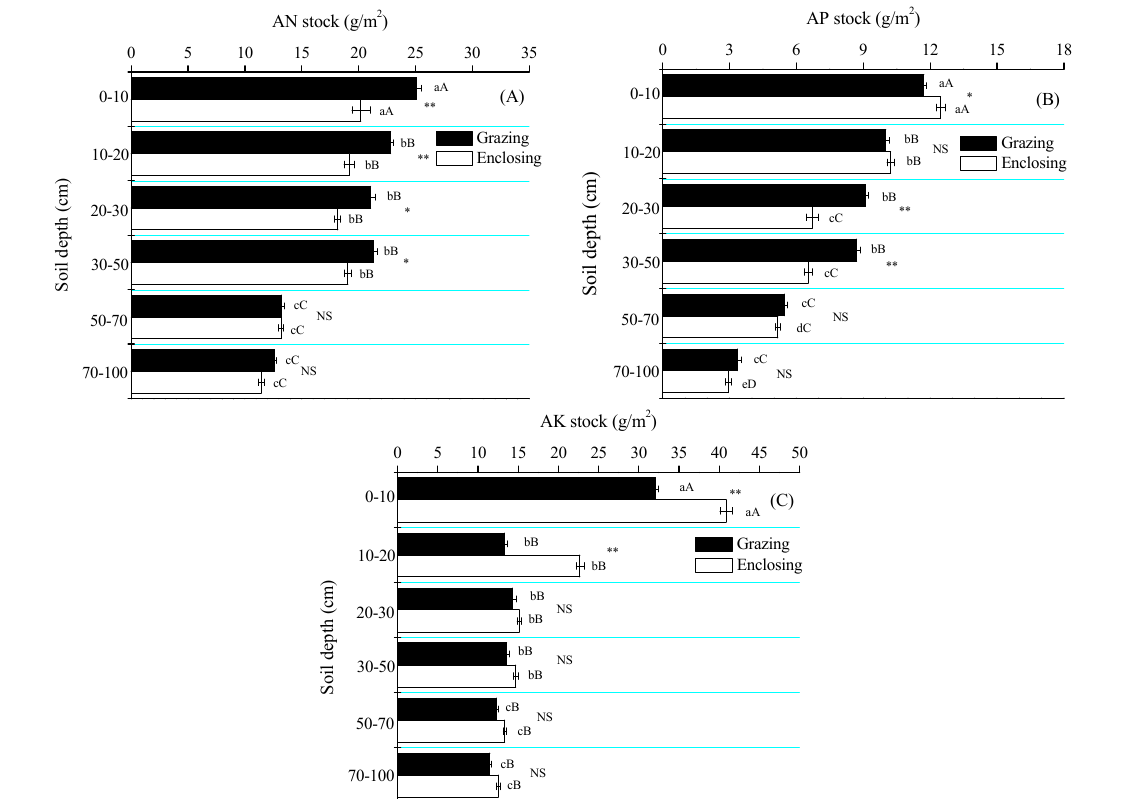
Figure 7. The soil AN ( A ), AP ( B ), and AK ( C ) stocks of treatments. Note: * and ** show significant differences at p < 0.05 and p < 0.01 of AN, AP, and AK stocks in each soil layer between two treatments, and NS shows no significant difference ( t -test). Lowercase and capital letters show significant differences at p < 0.05 and p < 0.01 of AN, AP, and AK stocks among different soil layers in each treatment by ANOVA. Error bars are one standard deviation.